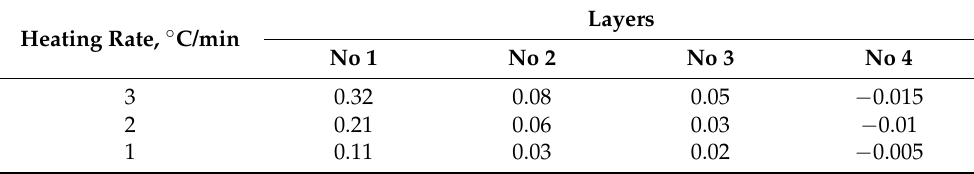
Table 3. Dependence of maximum stresses (MPa) in the layers of panel on the heating rate. Heating Rate, ◦ C/min